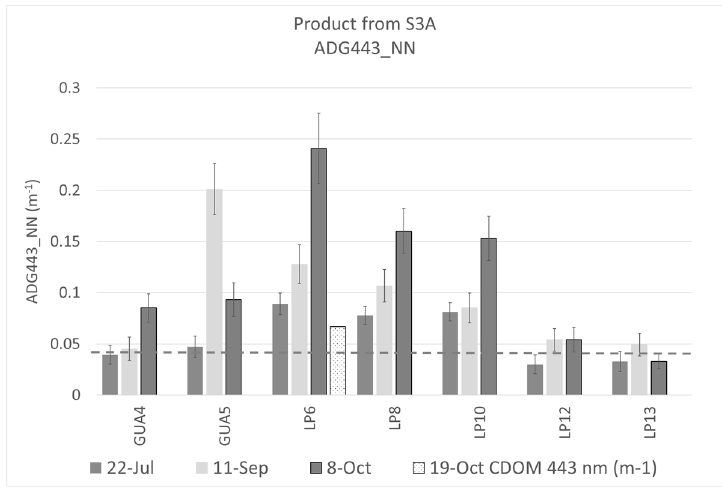
Figure 2. ADG443_NN product from Sentinel 3A for July 22, September 11, and October 8, 2017; the figure includes the aCDOM at 443 nm field data on October 19, 2017, at LP6 sampling site. The dashed line represents the second standard deviation (2SD) for aCDOM443 field data.